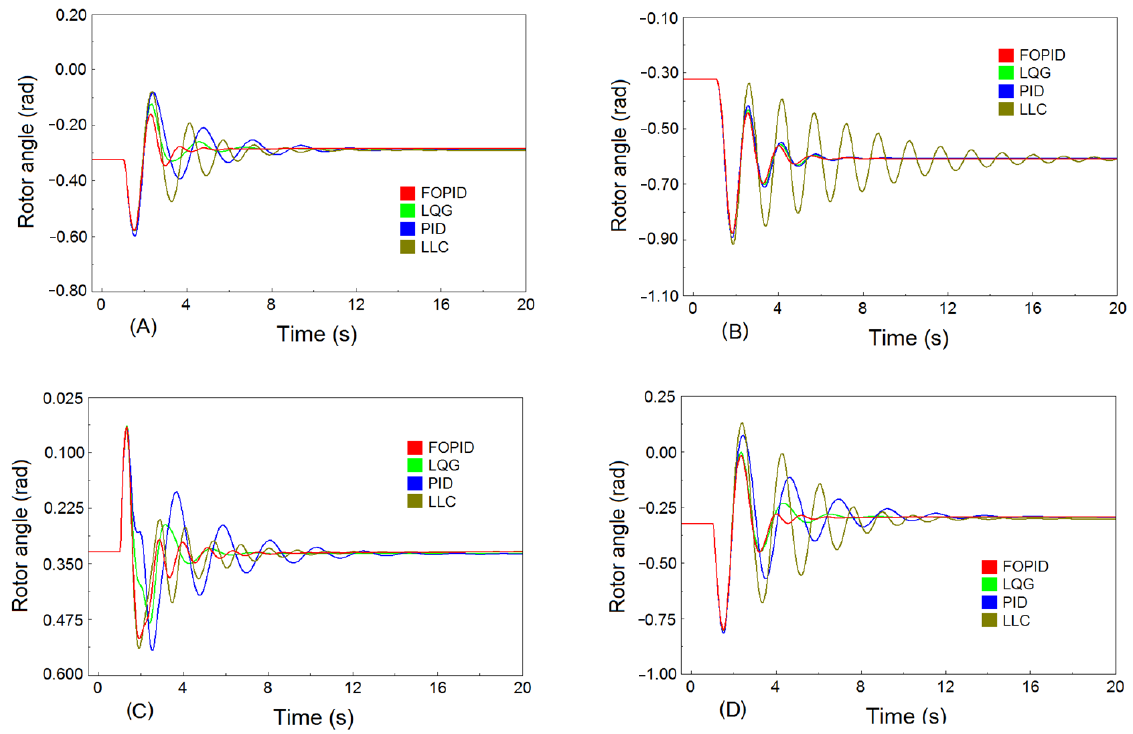
Figure 14. Rotor angle of generator G1 for scenario 2: ( A ) state 1, ( B ) state 2, ( C ) state 3, and ( D ) state 4.